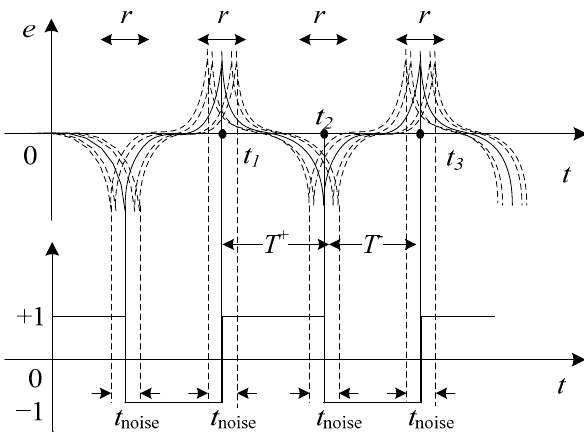
Figure 3. Noise effects in the bidirectional magnetic saturation time difference (BMSTD) readout.